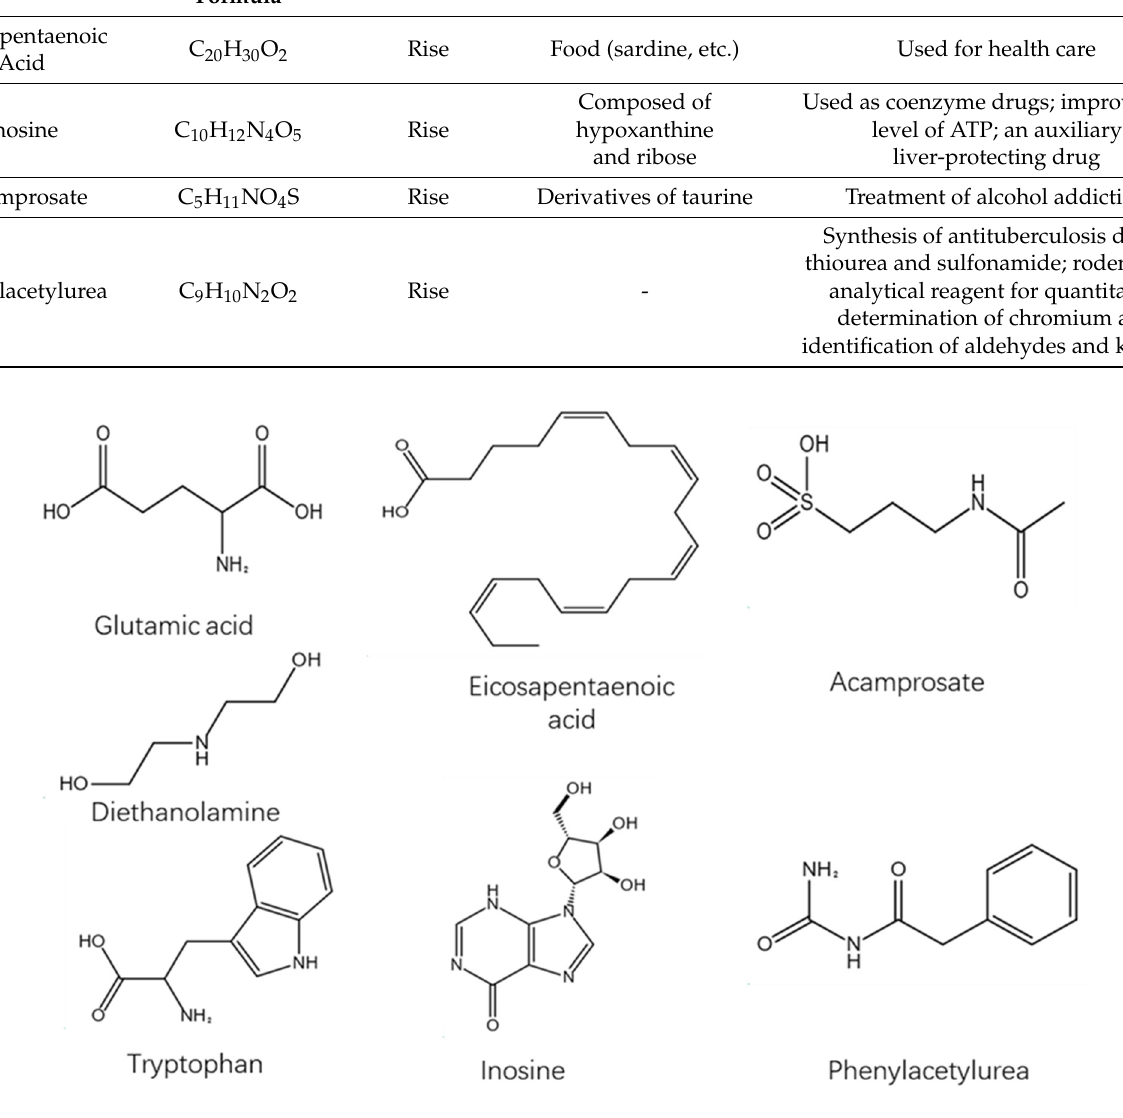
Figure 15. Structural formula of differential